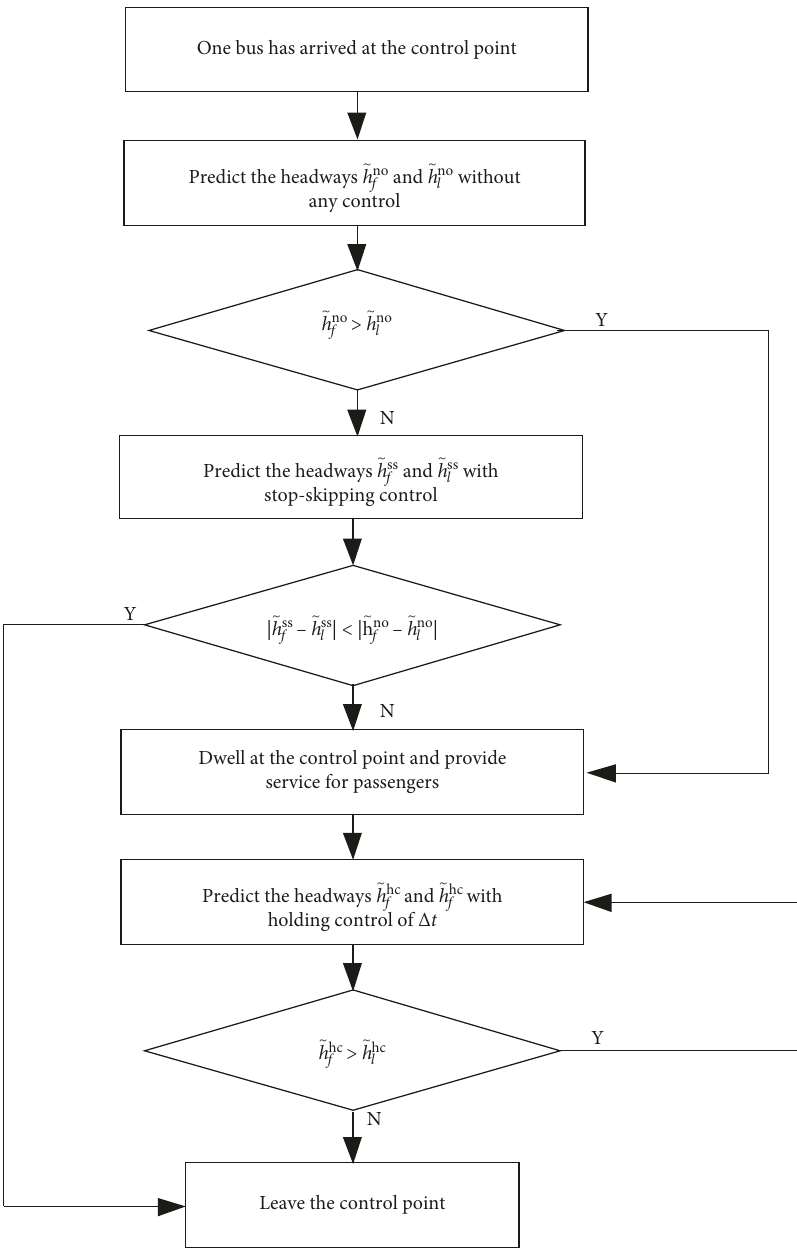
Figure 2: Principal control strategy procedure for bus operation at the control